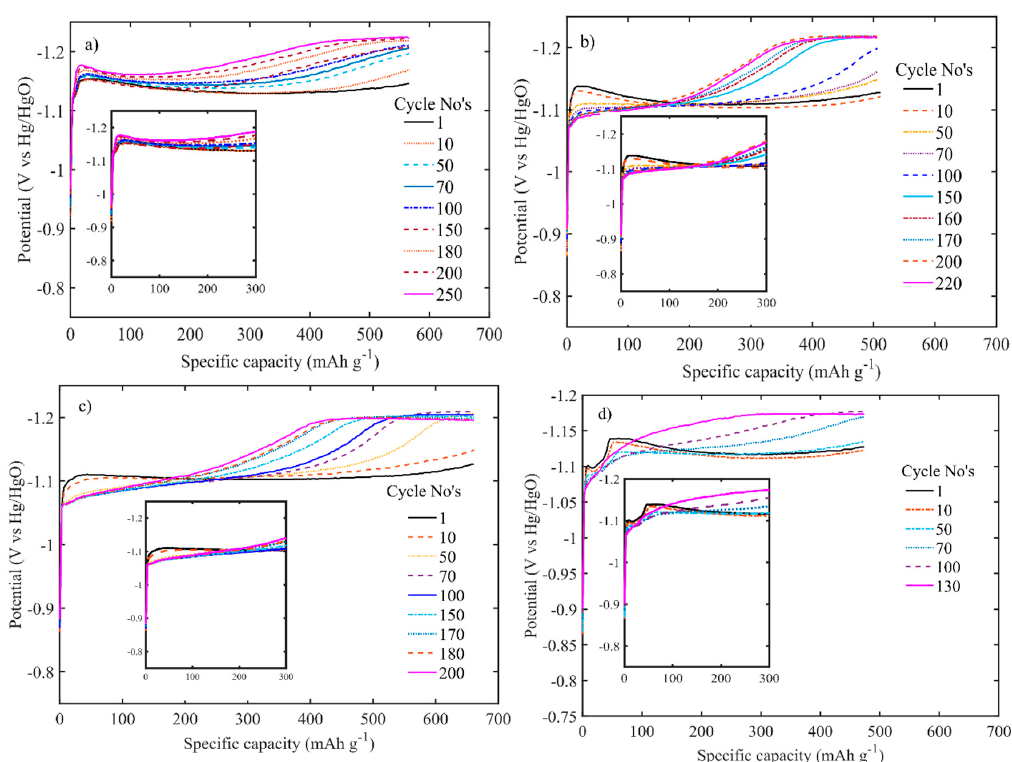
Figure 5. Specific discharge profiles of electrodes at current density of 100 mA g − 1 .